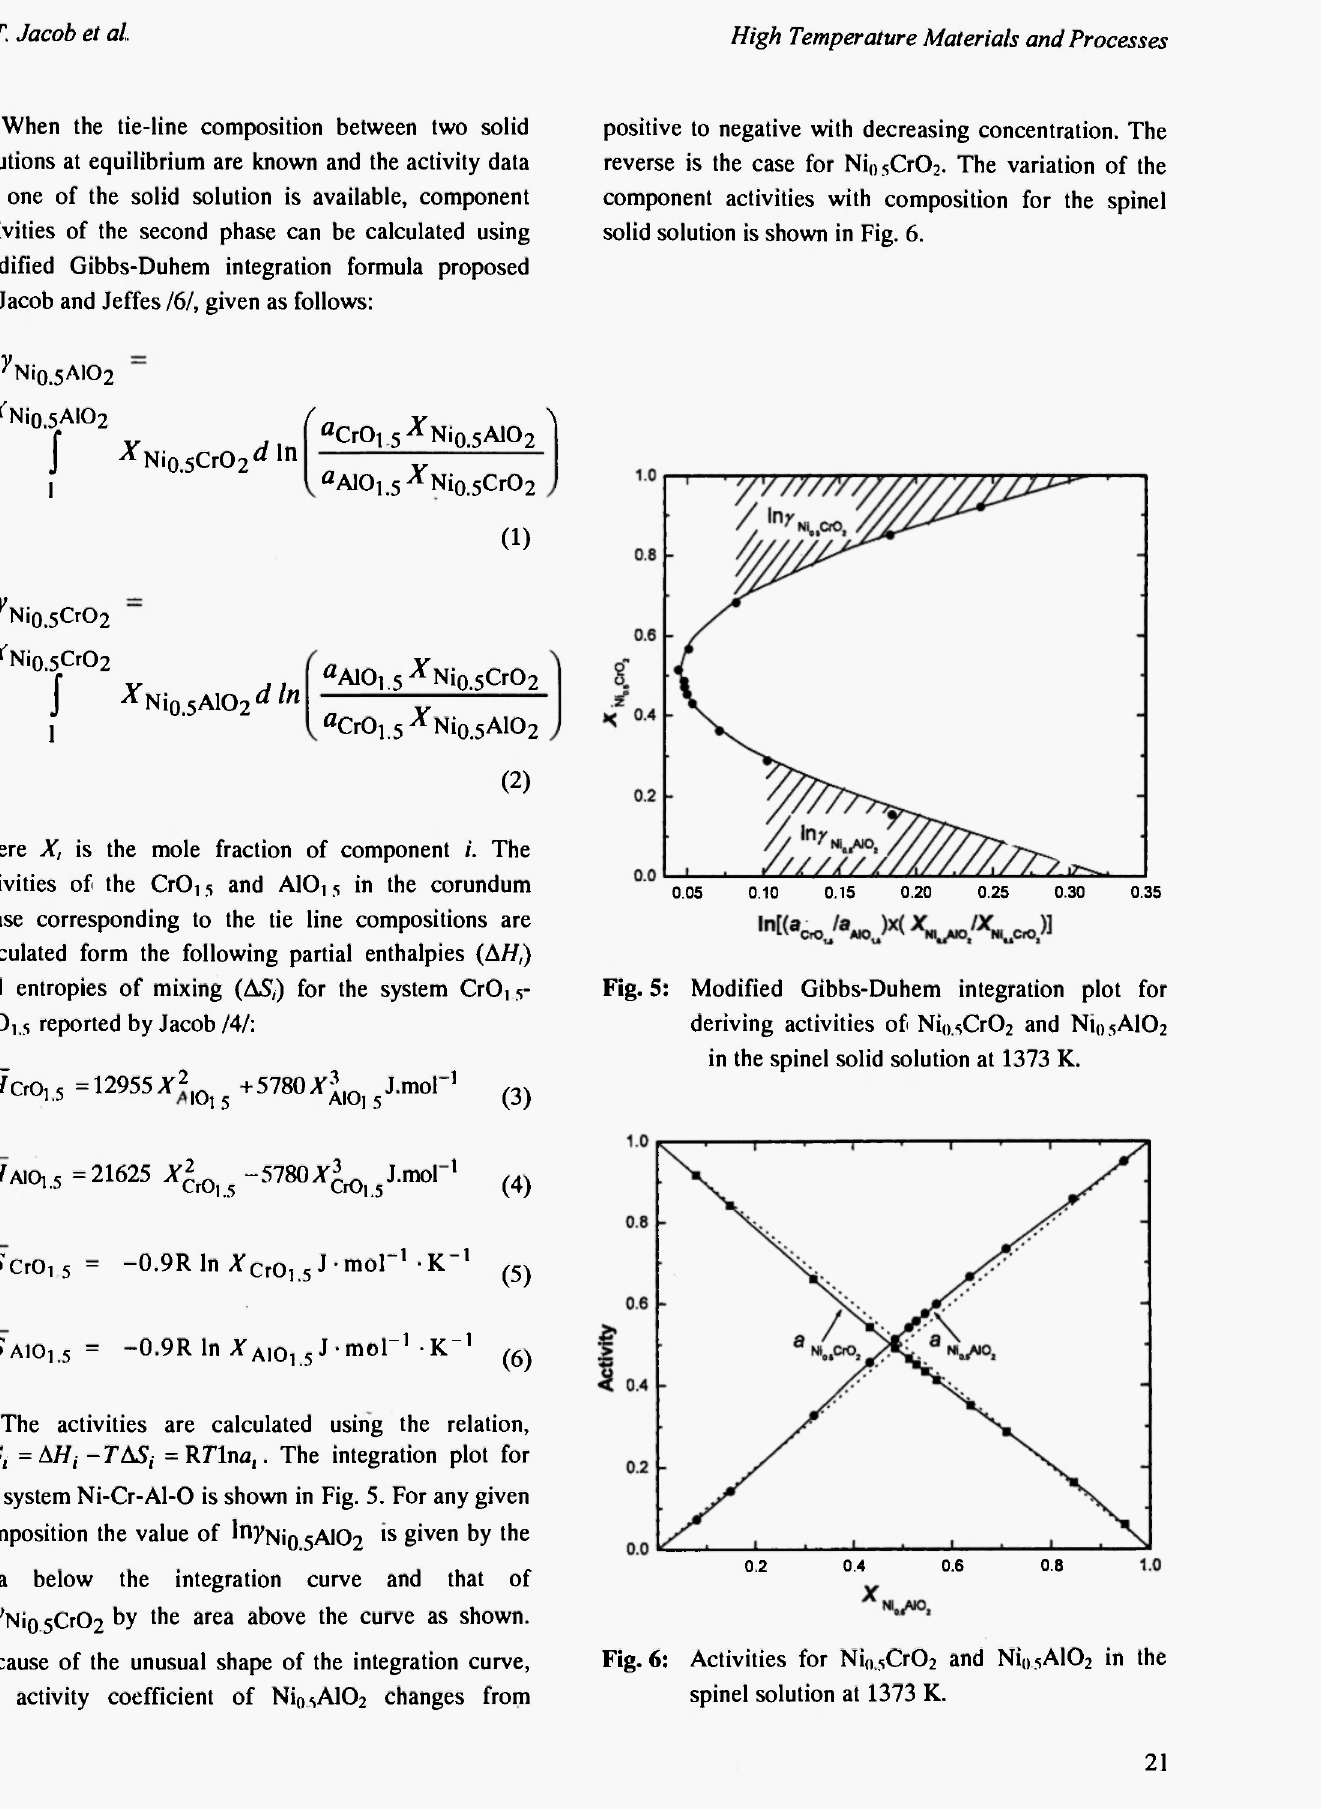
Fig. 6: Activities for Ni„.,Cr0 2 and Ni 05 AlO 2 in the spinel solution at 1373